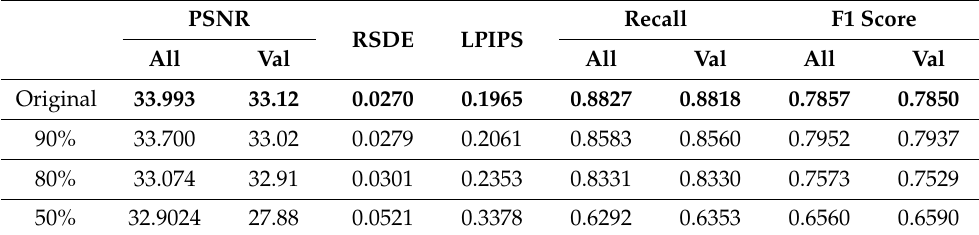
Table 2. Sparse sequence input training